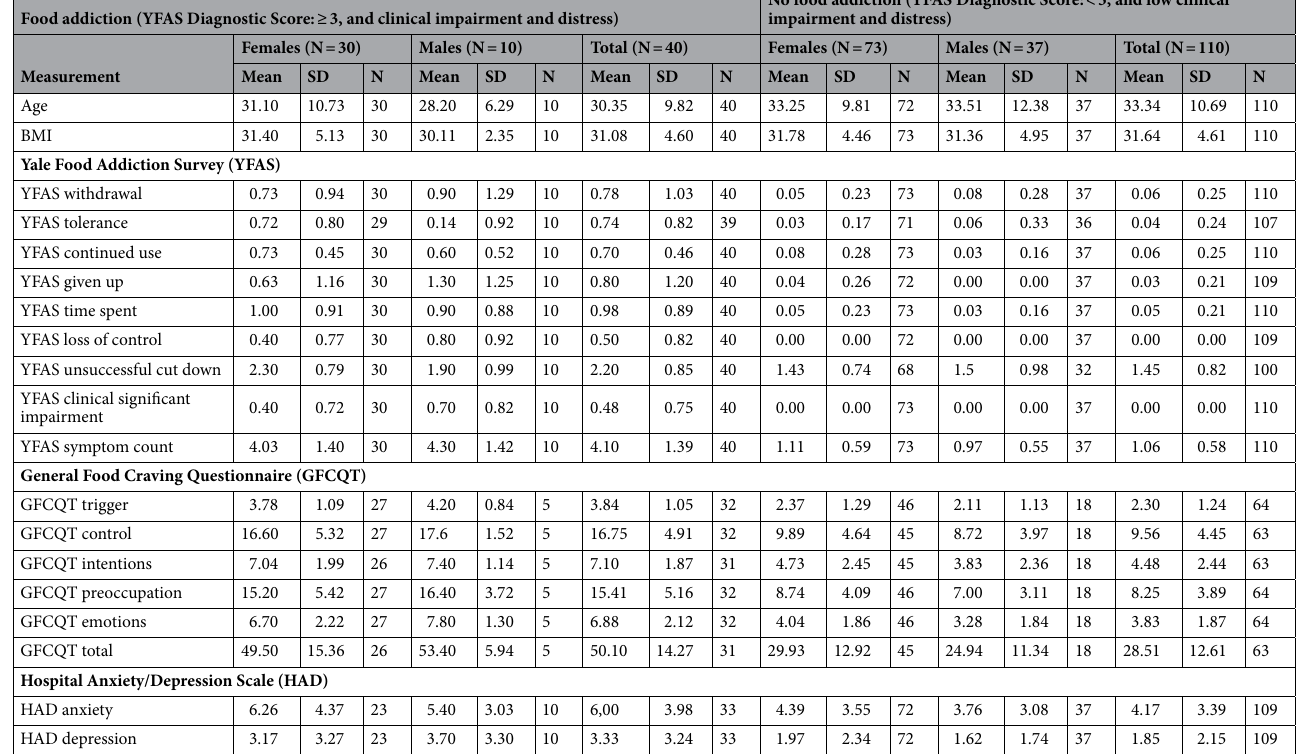
Table 1. Summary of Study Demographics and Clinical Behavioral Measures. Demonstrates study demographics and clinical behavioral measures for individuals with and without food addiction. BMI,